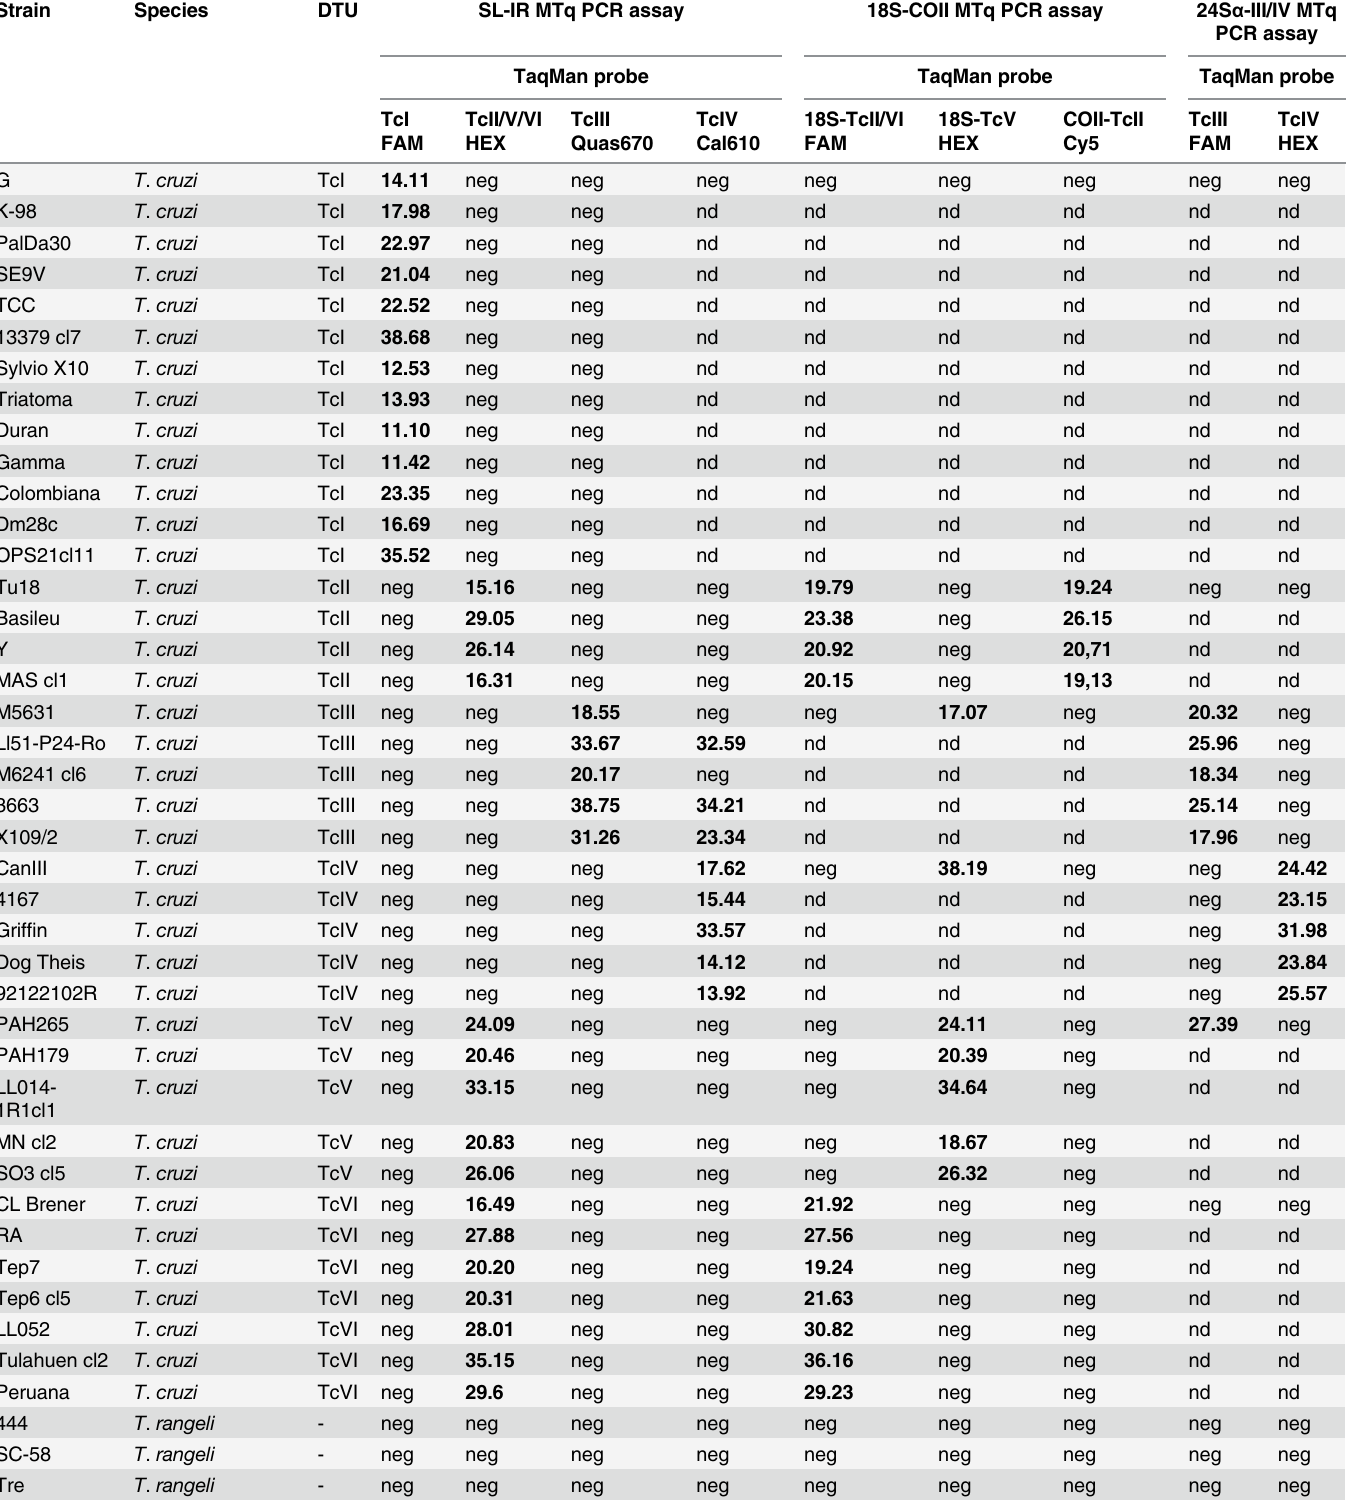
Table 3. Inclusivity and specificity assays for the multiplex real-time PCR genotyping algorithm. Strain